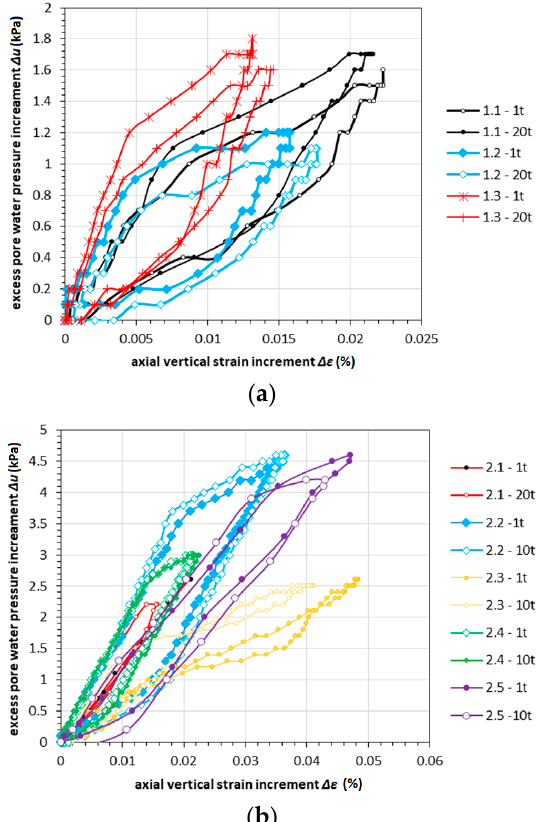
Figure 10. Pore pressure versus the axial strain for selected cycles from the triaxial tests: ( a ) Isotropically consolidated samples, and ( b ) K 0 -consolidated samples.